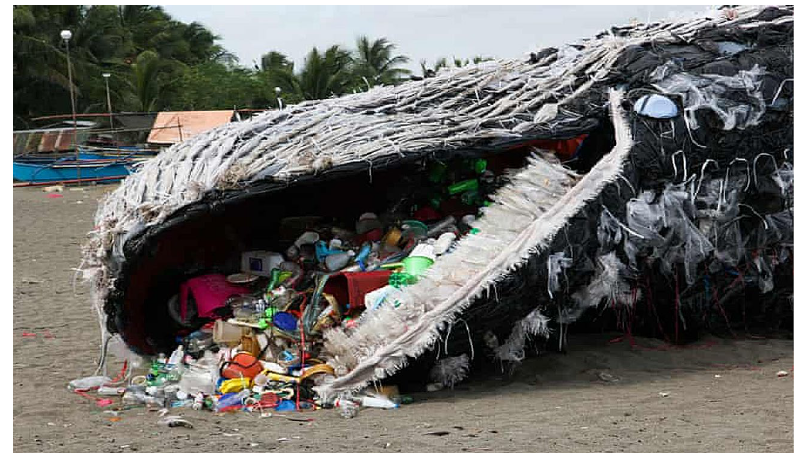
Figure 1. The whale swallowed plastic debris and died 2